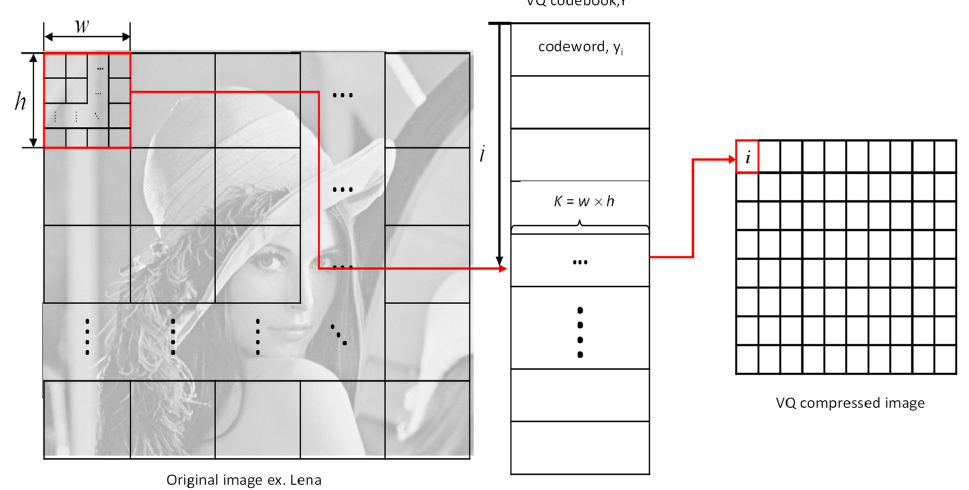
Figure 2. Example of VQ compression.